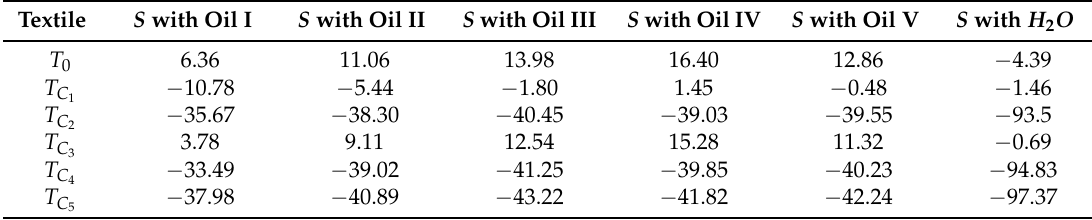
Table 8. Calculated spreading parameter S .